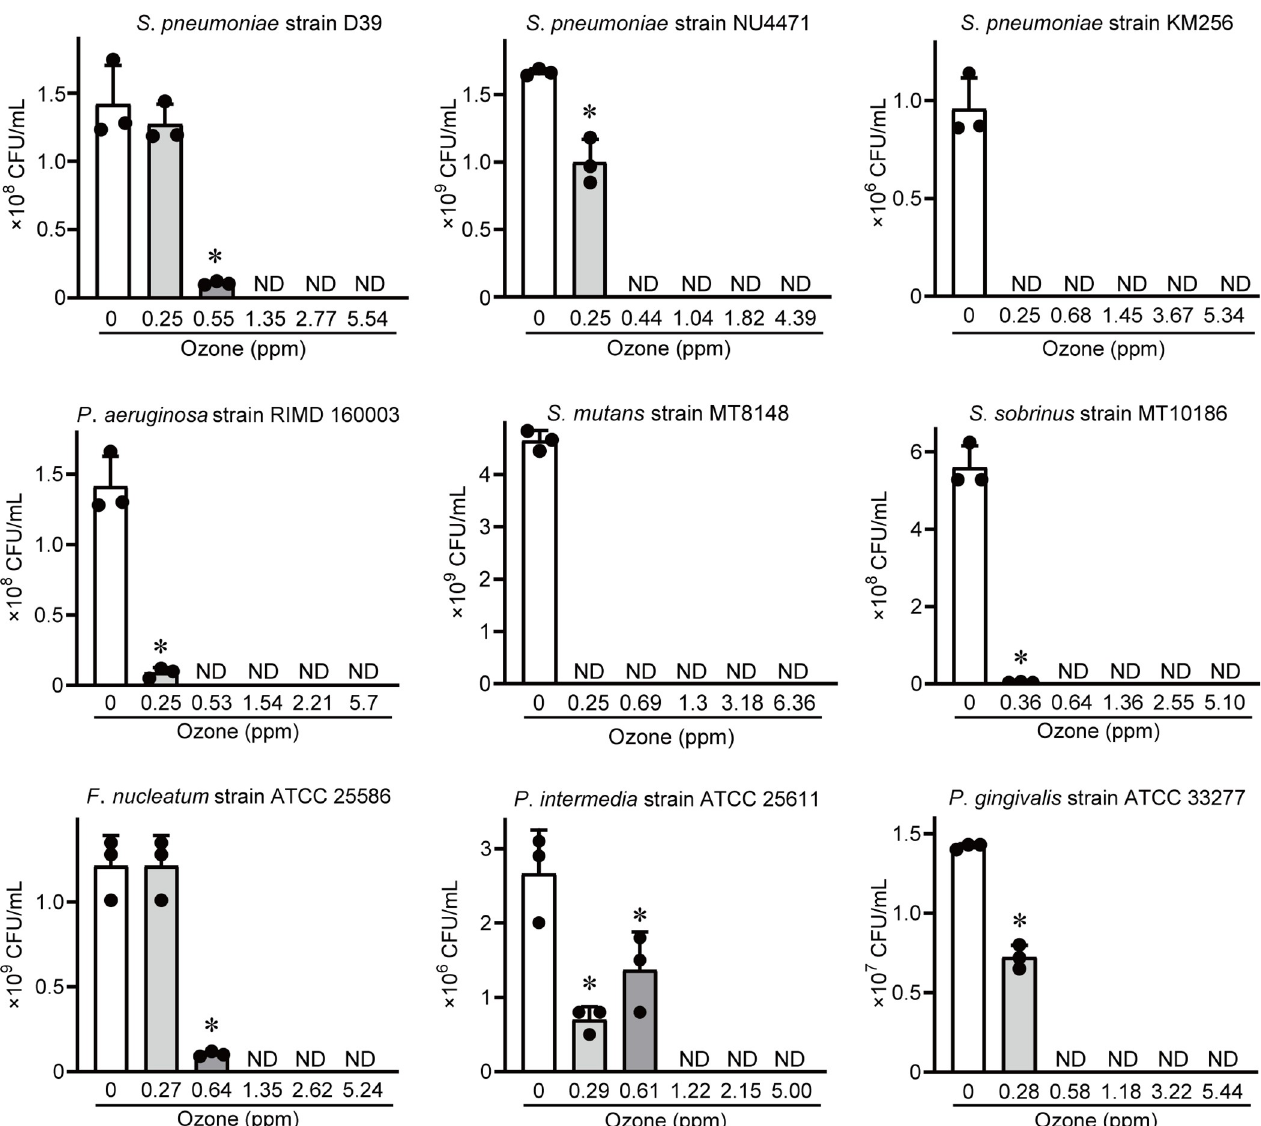
Fig 2. Bactericidal effects of ozone ultrafine bubble water (OUFBW) against various bacterial species. Various bacterial species were exposed to 0.25– 6 ppm OUFBW for 1 min. Data are presented as the mean ± SD of triplicate experiments and were evaluated using analysis of variance with a Dunnett’s multiple-comparisons test. * P < 0.05 compared to control group. ND stands for undetected and indicates below the detection limit ( < 100 CFU/mL).